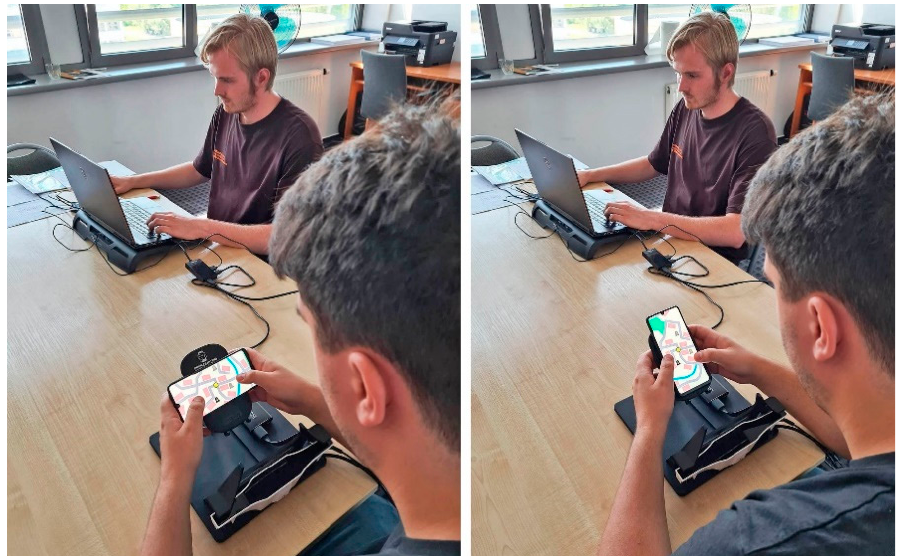
Figure 4. Researcher and participant with a smartphone in landscape and portrait orientation.